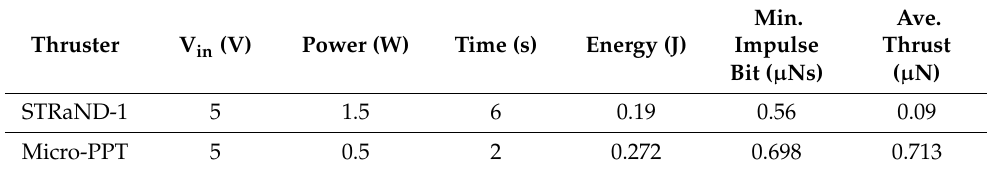
Table 2. Comparison of PPT and STRaND-1